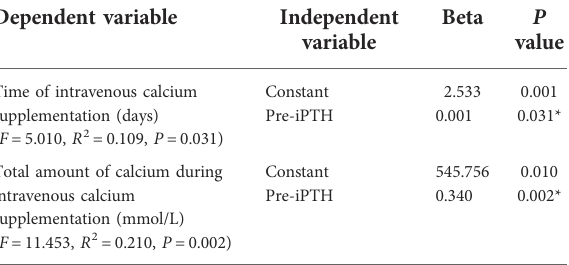
TABLE 3 In fl uence factors of maintenance time and total amount of intravenous calcium supplementation in patients with hypocalcemia (multiple linear stepwise regression